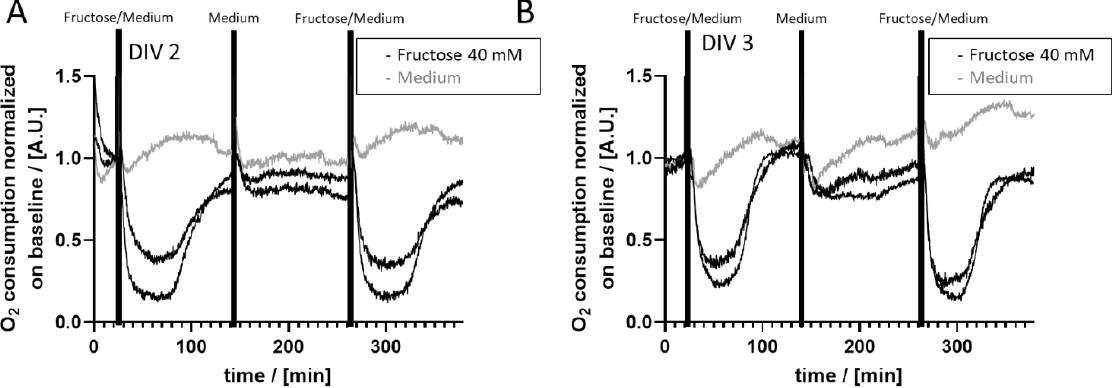
Figure 4: Repeated treatment of hepatocyte cultures by fructose on two consecutive days demonstrates the reproducibility of the effect of fructose on OC. The same cell culture chambers containing PHH were repeatedly treated for 2 hours with 40 mM fructose on DIV (days in vitro ) 2 ( A ) and DIV 3 ( B ). Fructose treatment reproducibly induced the initial decrease in OC followed by an increase to almost initial levels (black graphs). In addition, the intensity of the relative fructose effect on OC is comparable intra-day as well as inter-day. In order to allow the cells to equilibrate to normal metabolic conditions, cells were cultured in standard culture medium for 2 hours in between fructose treatments. Cells cultured in stand- ard medium, did not show substantial changes in OC (grey